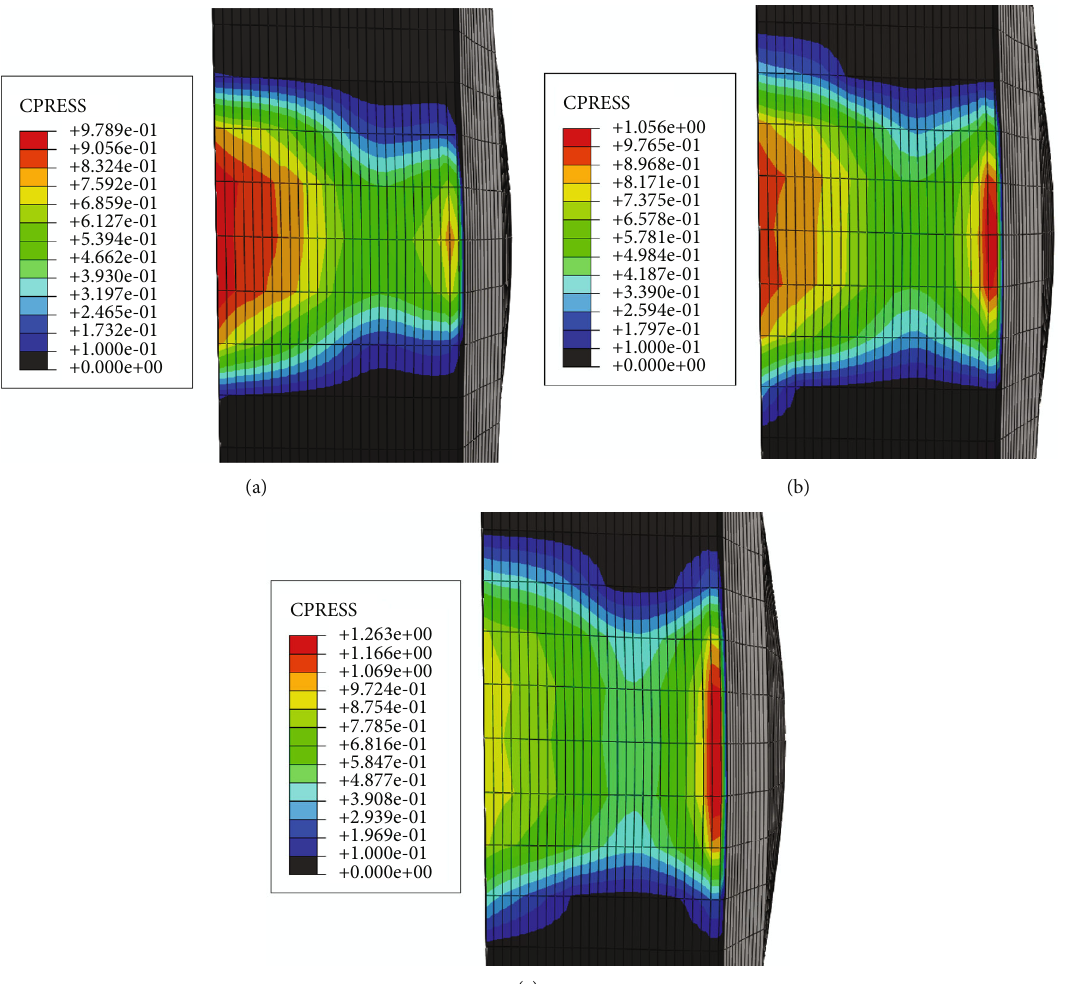
Figure 10: Grounding stress distribution of a 3D tire model under 0.5MPa of in fl ation pressure under loads of (a) 466670 N, (b) 555550N, and (c) 633330